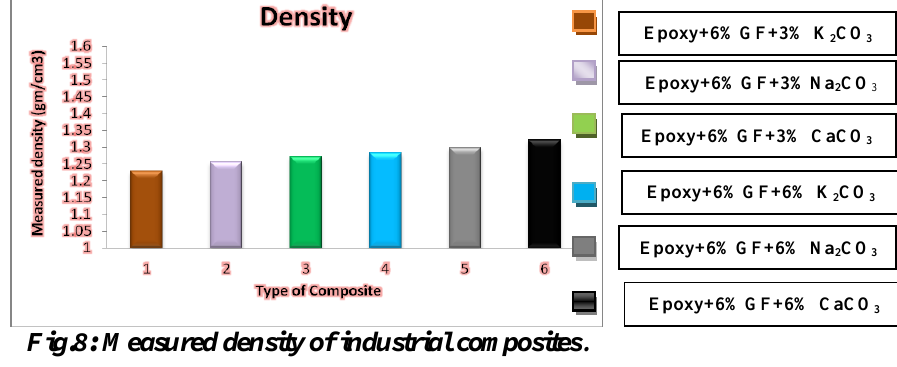
Fig.8: Measured density of industrial composites .